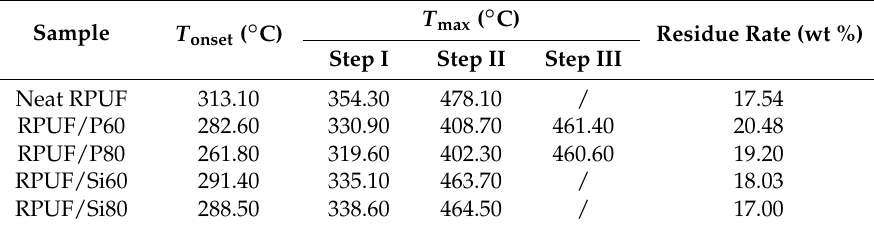
Figure 8. DTG curves for RPUF. Table 4. The parameters of TG and DTG of